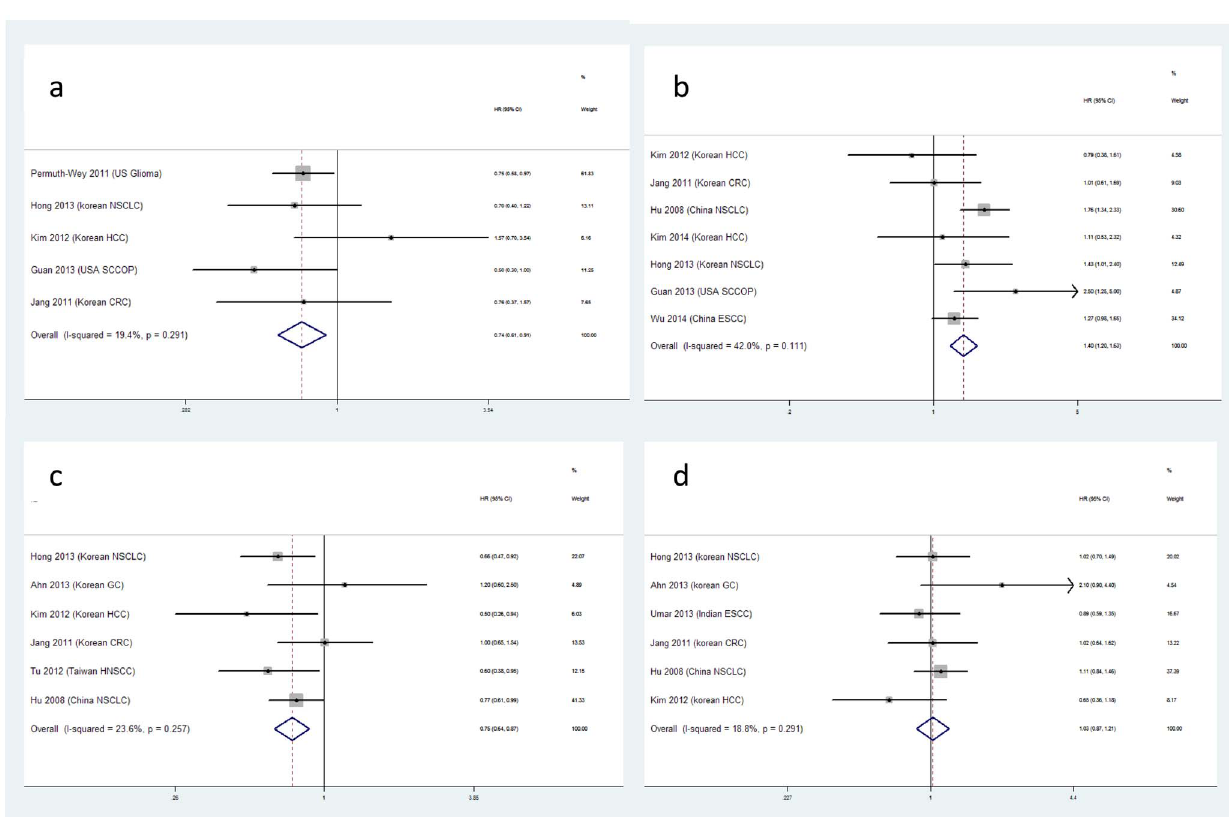
Figure 2. The main results of meta-analysis for the four genetic polymorphisms. The forest plots for pooled HR and 95%CI estimated to demonstrate the role of mir-146a in Dominant model(a), mir-196a2 in Recessive model(b), mir-149 in Dominant model(c) and mir-499 in AG vs AA(d) in overall survival.